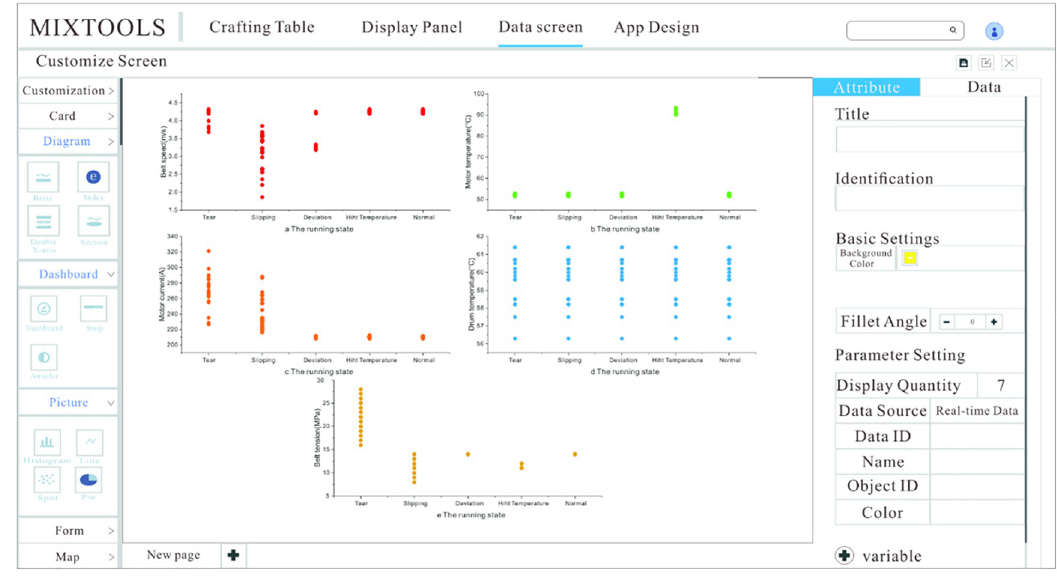
Fig 9. Distribution of characteristic